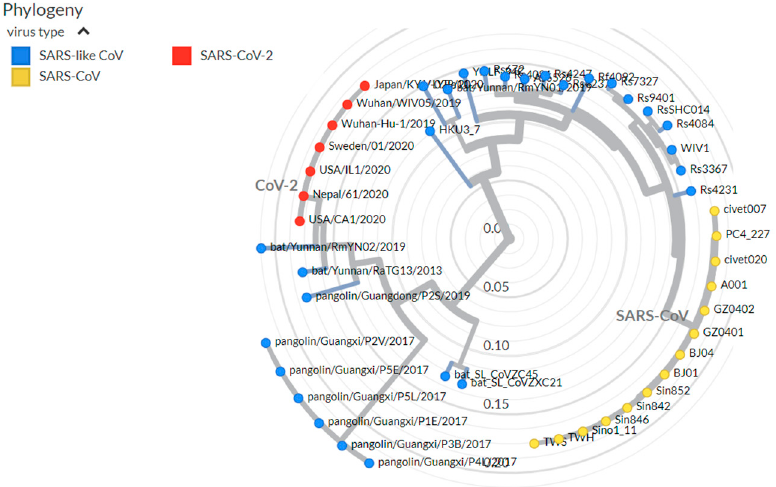
Figure 2. Phylogeny of SARS-like betacoronaviruses including SARS-CoV-2, showing 49 genomes. Adapted from Nextstrain (https://nextstrain.org/groups/blab/sars-like-cov, accessed on 8 February 2022).